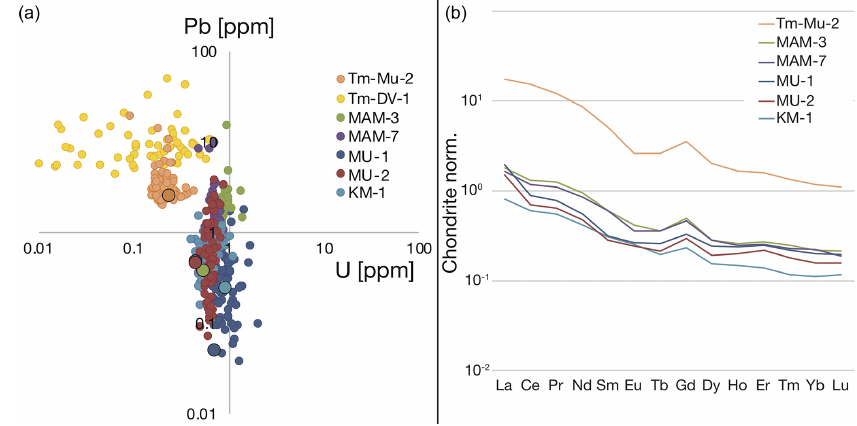
Figure 4. (a) U vs. Pb (ppm) of single-spot analyses by LA-ICP-MS of the studied dolomite samples, together with the whole-rock U and Pb content of each sample (large circles). (b) Corresponding whole-rock REE patterns normalized to chondrite